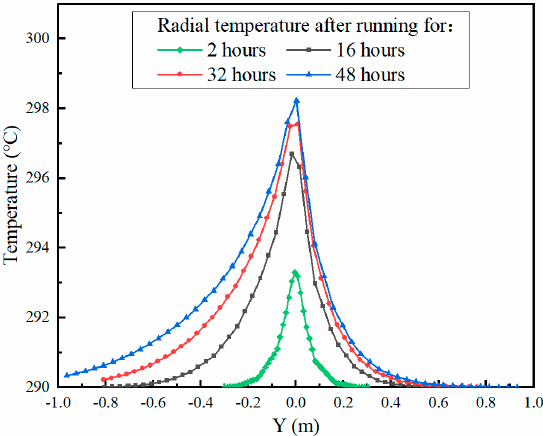
Figure 13. Radial temperature distribution of CPB along the Y ‐ direction (X = 0 m) with a hydraulic conductivity of 2 × 10 − 6 m/s.